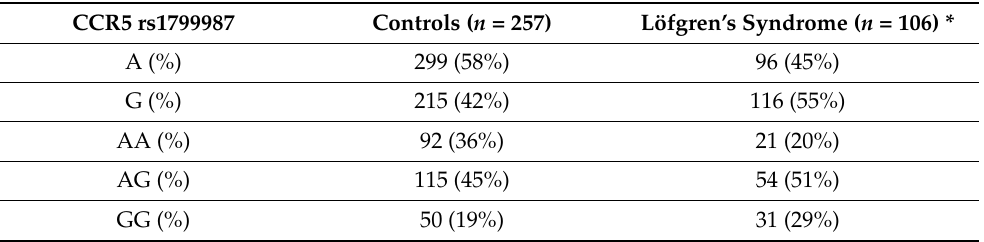
Table 1. Allele and genotype frequencies of rs1799987 in controls and patients with Löfgren’s